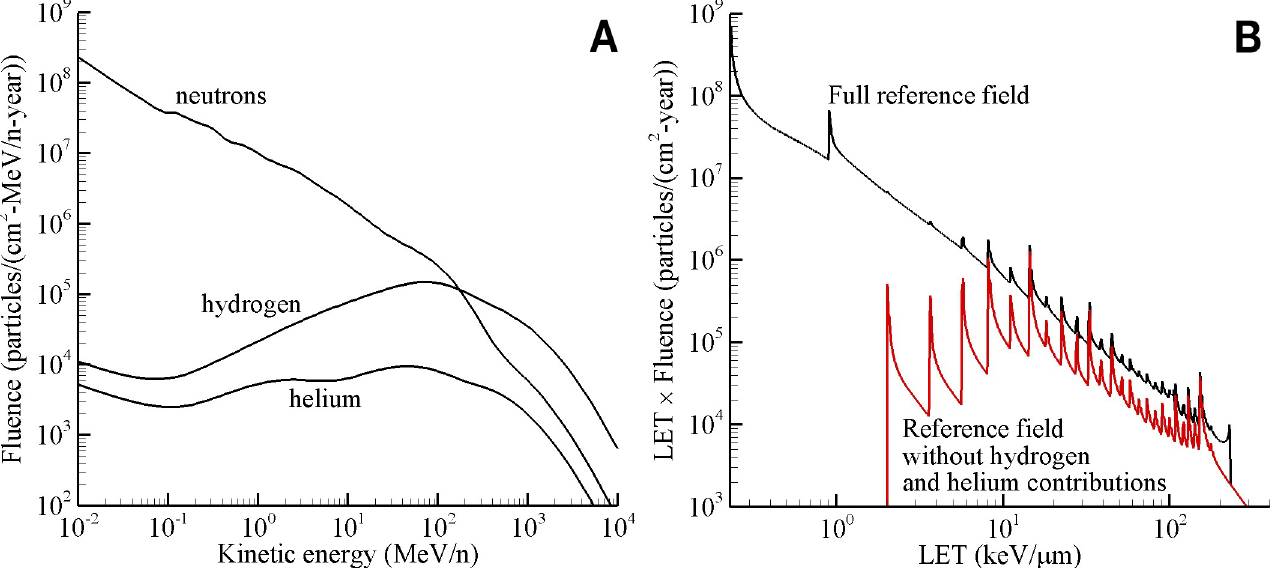
Fig 6. Reference field spectra in the female BFOs behind 20 g/cm 2 of aluminum shielding during solar minimum conditions. (A) Neutron, hydrogen, and helium energy spectra. (B) The corresponding differential LET spectra with and without contributions from hydrogen and helium. Based on calculations from Slaba and colleagues, 2016 [8]. Plot data available in S1 Data. BFO, blood forming organ; LET, lineal energy transfer.